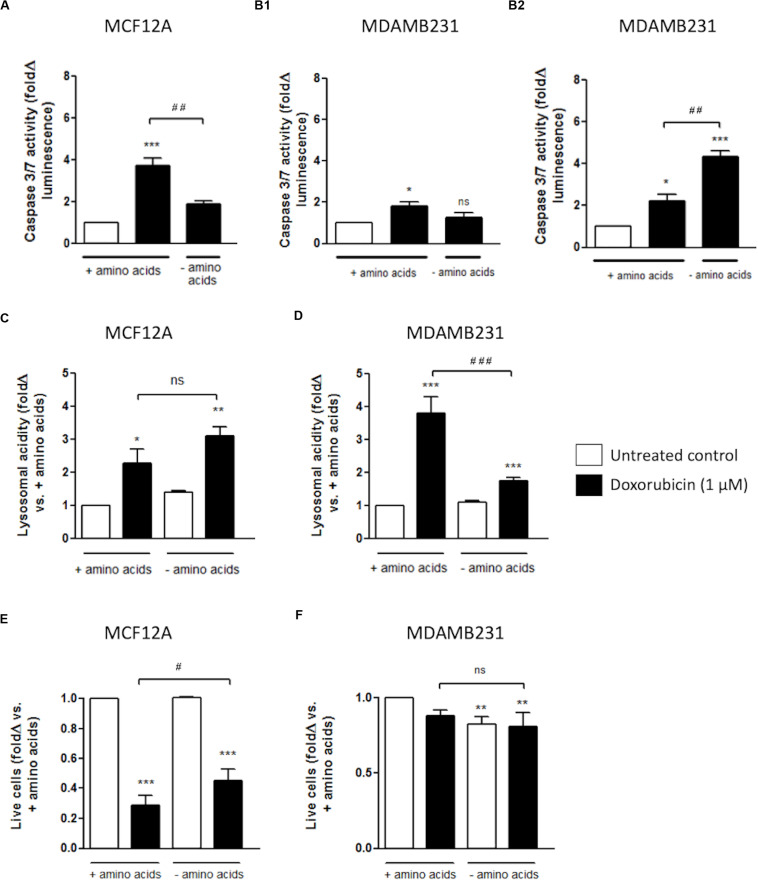
The effect of amino acid starvation in MCF12A and MDAMB231 cells following Dox treatment. Caspase 3/7 activity in amino acid-starved MCF12A after 24 h (A) and MDAMB231 cells after 12 (B1) and 24 h (B2) following Dox treatment. Lysosomal acidity in amino acid-starved MCF12A (C) and MDAMB231 (D) cells following Dox treatment. Trypan blue positive cell staining in amino acid-starved MCF12A (E) and MDAMB231 (F) cells following Dox treatment. Results represent the fold change in cultures incubated with Dox vs. untreated cells. Cells were incubated in Dox and/or in amino acid deprived medium for 24 h where applicable. Each value represents the mean ± SEM of at least three independent determinations. *p < 0.05; **p < 0.01; ***p < 0.001; #p < 0.05; ##p < 0.01; ###p < 0.001; ns, no significance.